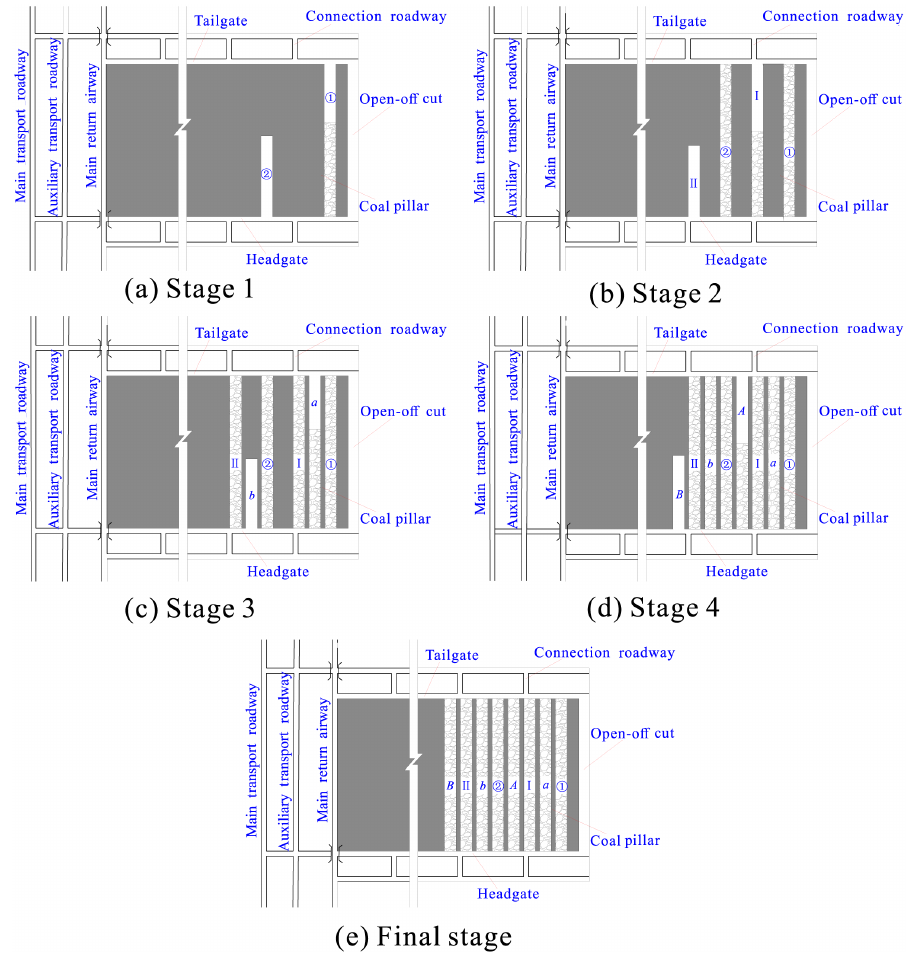
Figure 15. Design of the driving and filling sequence in the backfill of the driving roadway during mining.